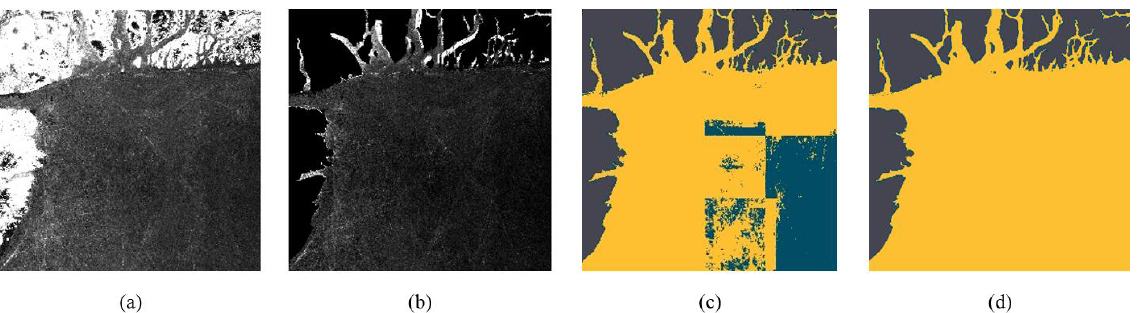
Figure 19. Example of a misclassification due to a mismatch between the S1-imaged land and GSHHG mask. (a) HV-polarized S1 image with no land mask. Panels (b) and (c) are HV-polarized S1 images with the land mask, stretched with a threshold of 2%, and the corresponding misclassification result. Panels (d) and (e) are HV-polarized S1 images with the land mask, stretched with a threshold of 5%, and the corresponding correct result. (Image ID: